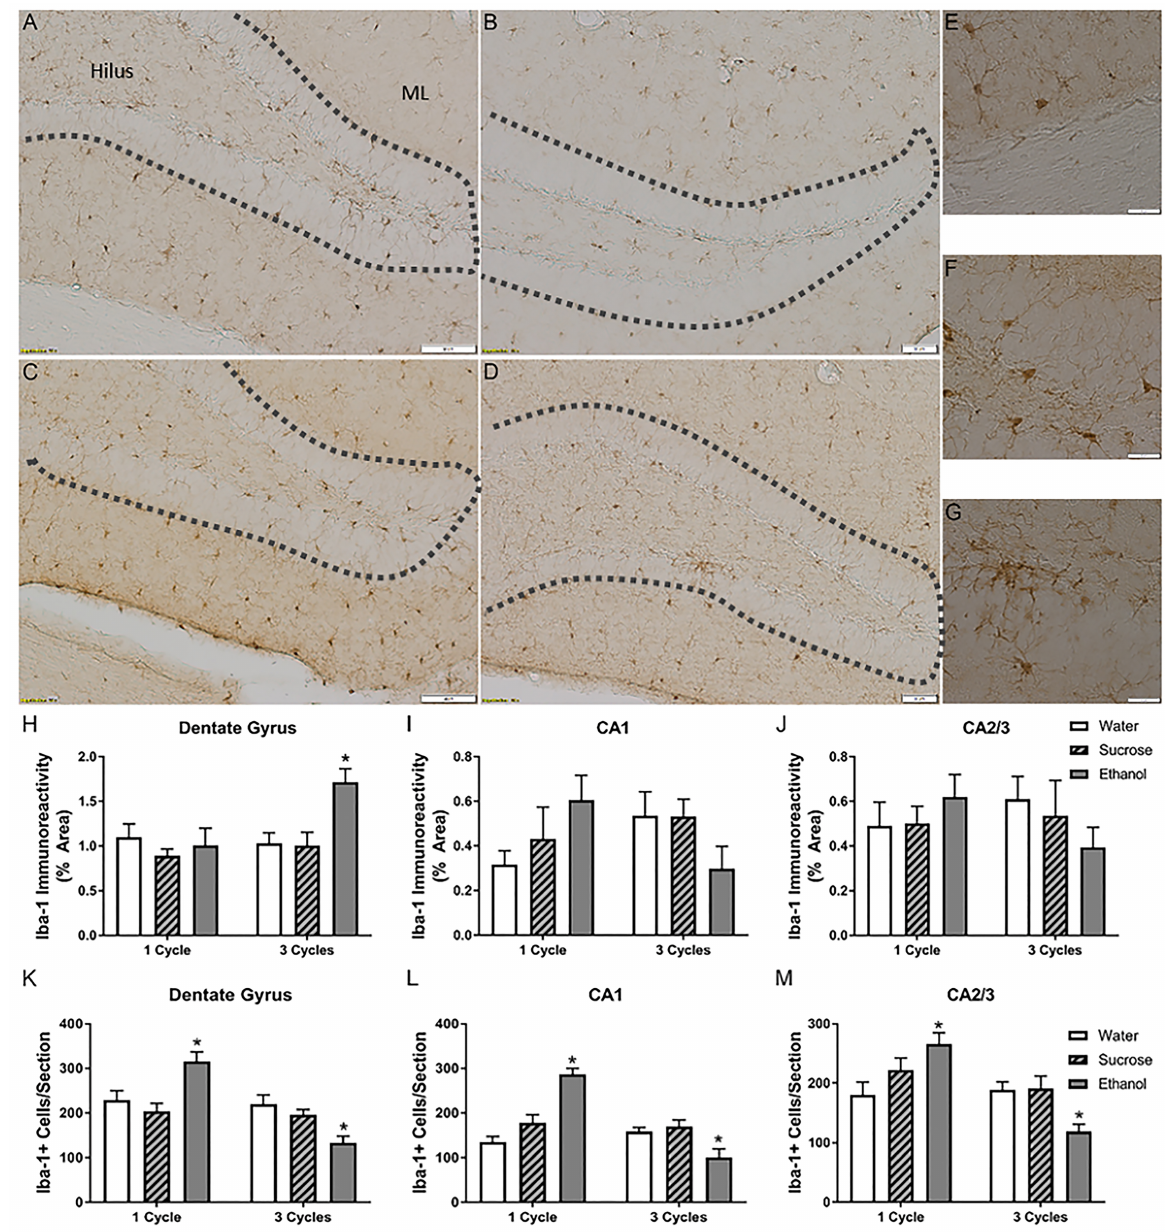
Fig. 2. Binge-like consumption changes hippocampal microglia. Iba-1 immunoreactivity was upregulated in the dentate gyrus. Representative photomicrographs of the dentate gyrus of mice given access to 3 cycles of water (A), 3 cycles of sucrose (B), 1 cycle of EtOH (C), or 3 cycles EtOH (D). The